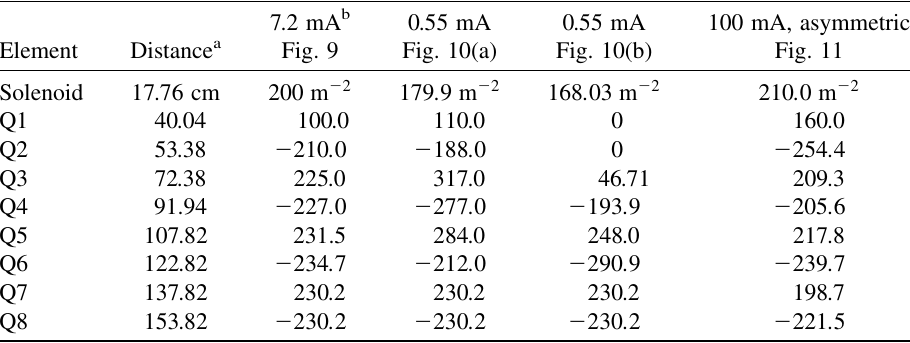
TABLE V. Parameters for (symmetric) source-to-FODO matching solutions in UMER for 7.2 mA (one solution) and 0.55 mA (two solutions), 10 keV, (cid:5) corresponds to asymmetric source-to-FODO matching of 100 mA, 10 keV, with (cid:5) (cid:5) 73 : 4 (cid:12) . (cid:5) 0 y